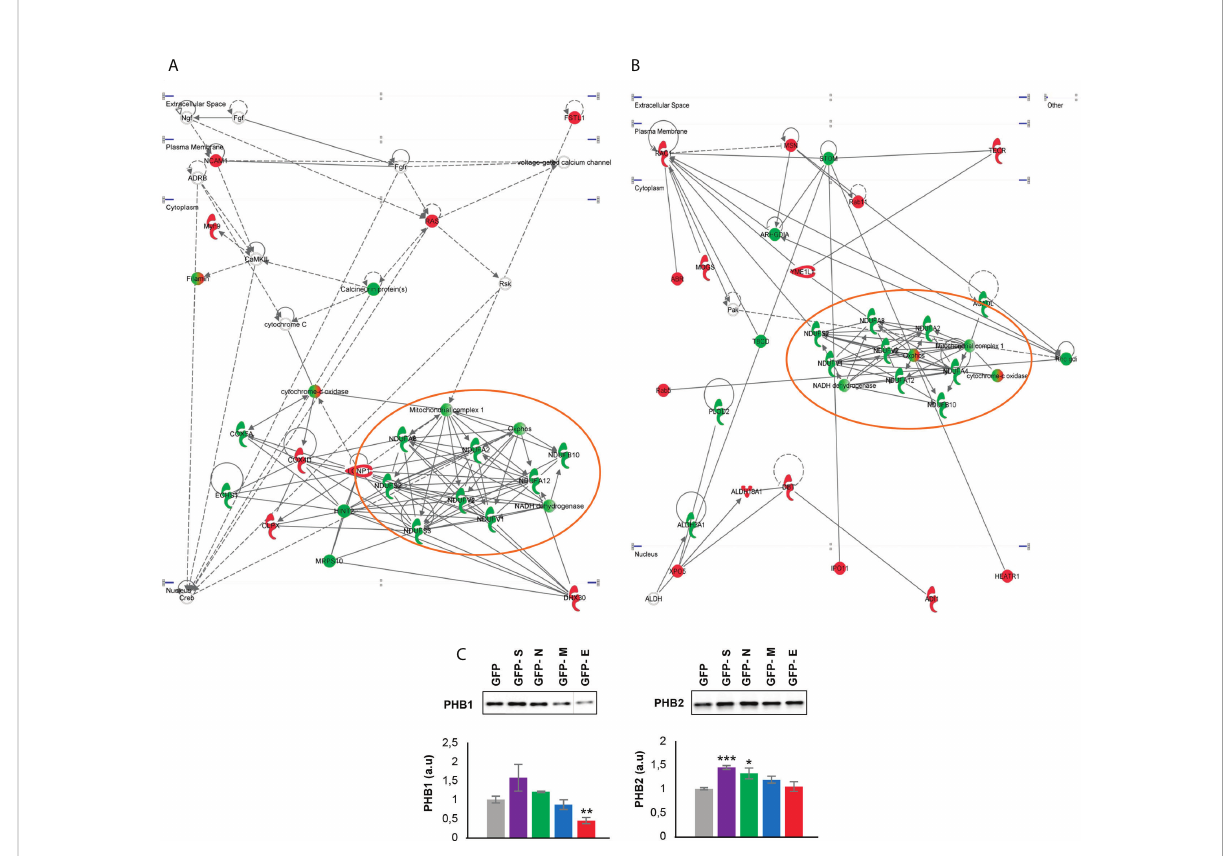
FIGURE 6 Functional protein interactome maps for differentially expressed proteins in GFP- SARS-CoV-2 E and M protein-expressing OBC1 cells, revealing a mitochondrial impairment (A, B) . OB expression of Phb complex by Western blot (C) . Equal loading of the gels was assessed by stain-free digitalization. Panels show histograms of band densities. Data are presented as mean ± SEM from four independent biological replicates. *P < 0.05 vs. GFP; **P < 0.01 vs. GFP; *** P < 0.001 vs. GFP (a.u: arbitrary